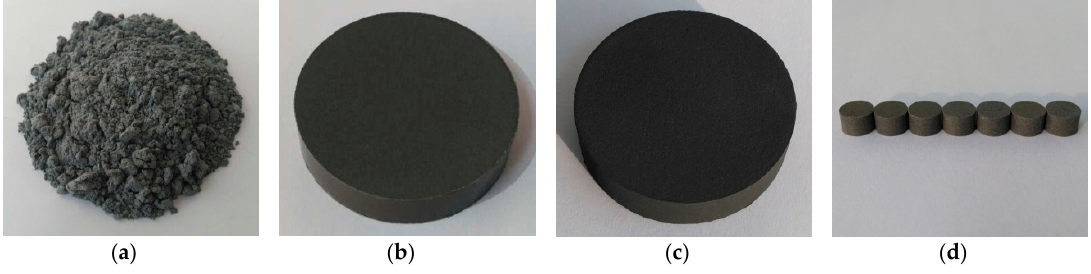
Figure 2. Photographs of PTFE/Ti/W composites at various preparation stages: ( a ) powder mixture; ( b ) pressed billet; ( c ) sintered billet; ( d ) experimental samples. Table 1. Densities of the PTFE/Ti/W composites.